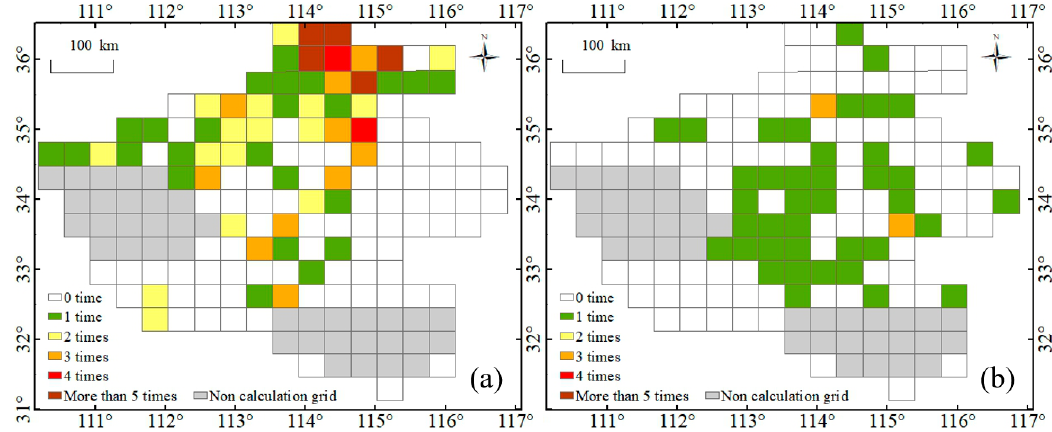
Figure 8. Irrigation frequency maps during the growth seasons for ( a ) winter crops and ( b ) summer crops.